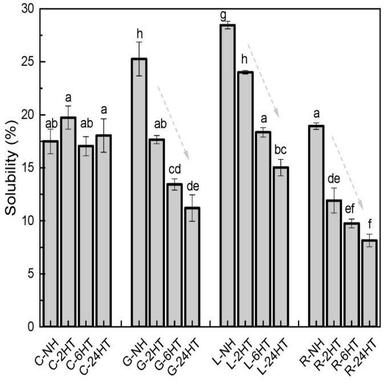
Solubility values of fish gelatin-based films as a function of saccharide (glucose (G), lactose (L), and ribose (R)) and heating time (non-heated (NH), heat-treated (HT) for 2, 6 and 24 h). Films with no saccharide were used as control (C). Two means followed by the same letter are not significantly (p > 0.05) different according to the Tukey's multiple range test (n = 3).